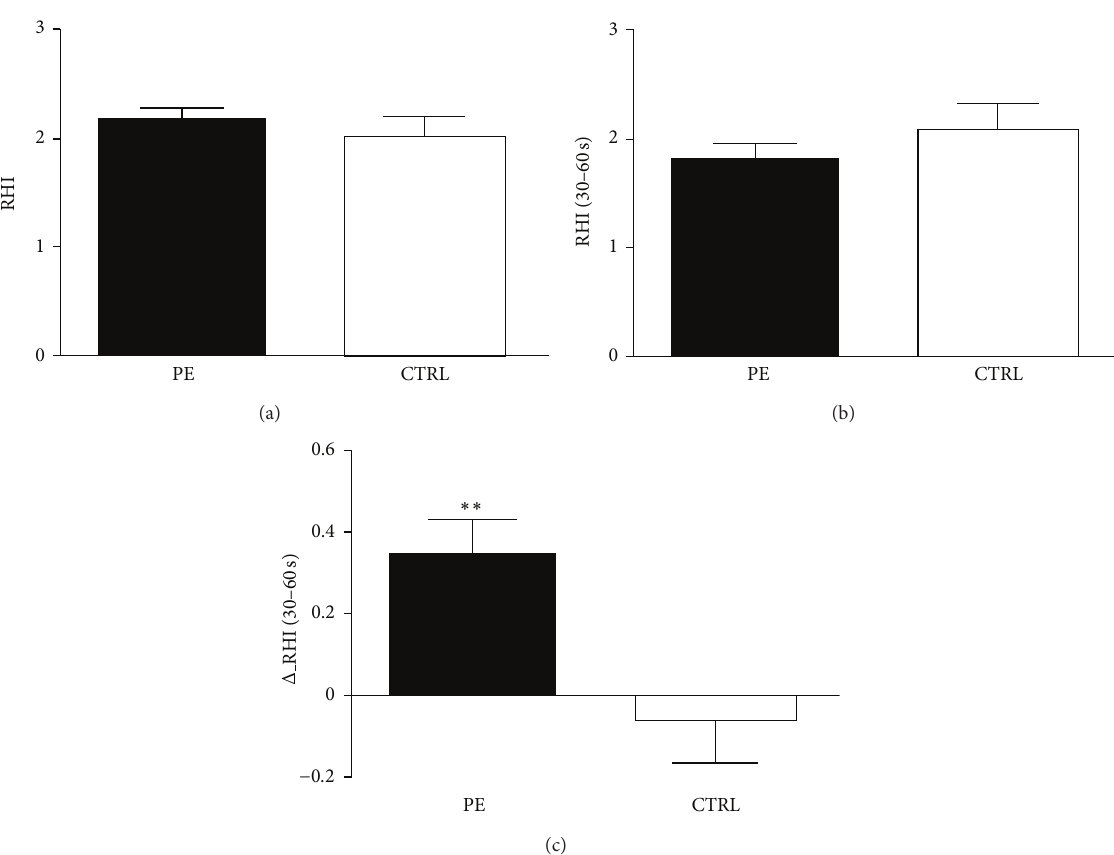
Figure 2: RHI values at baseline in different groups. The difference between groups is significant only when calculated as a linear variation of increment from baseline (delta RHI). PE = premature ejaculation. CTRL =